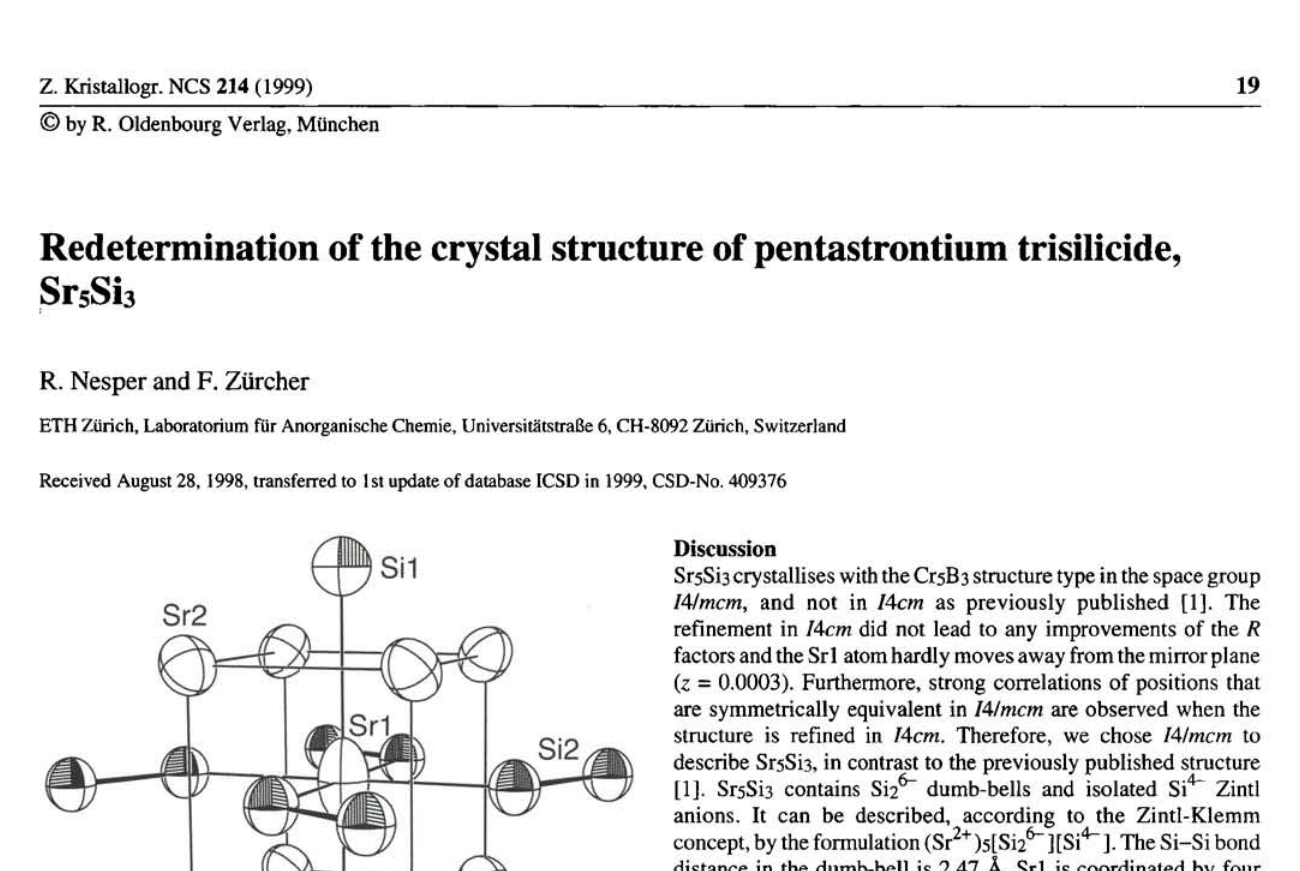
Table 1. Data collection and handling. Crystal: Wavelength: μ: Diffractometer, scan mode: 29max: N(hkl) measured, N(hkl) unique: Criterion for / 0 bs, Nfhkljp: N(param)